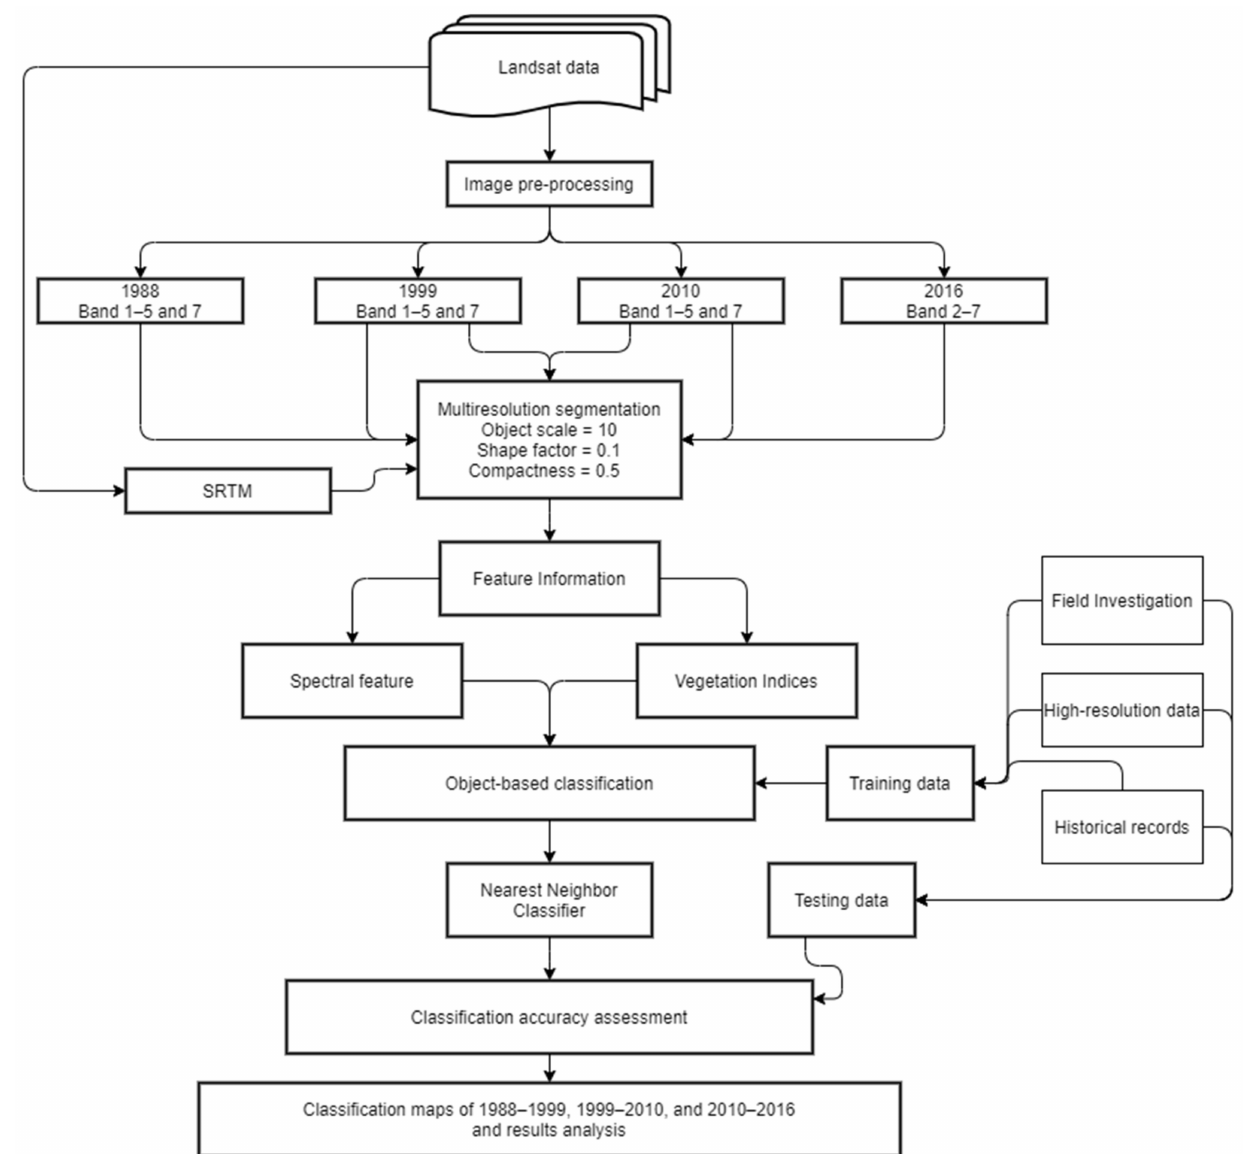
Figure 3. Flowchart for object-based classification based on Landsat images. After segmentation, three vegetation indices (NDVI, NDWI (normalized difference water index), and NBR) and band values (RED, NIR (near-infrared), SWIR1